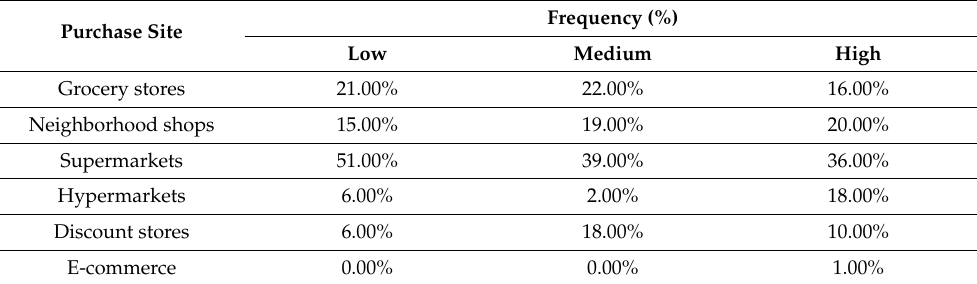
Table A3. Purchase sites by frequency of food purchase (in % of